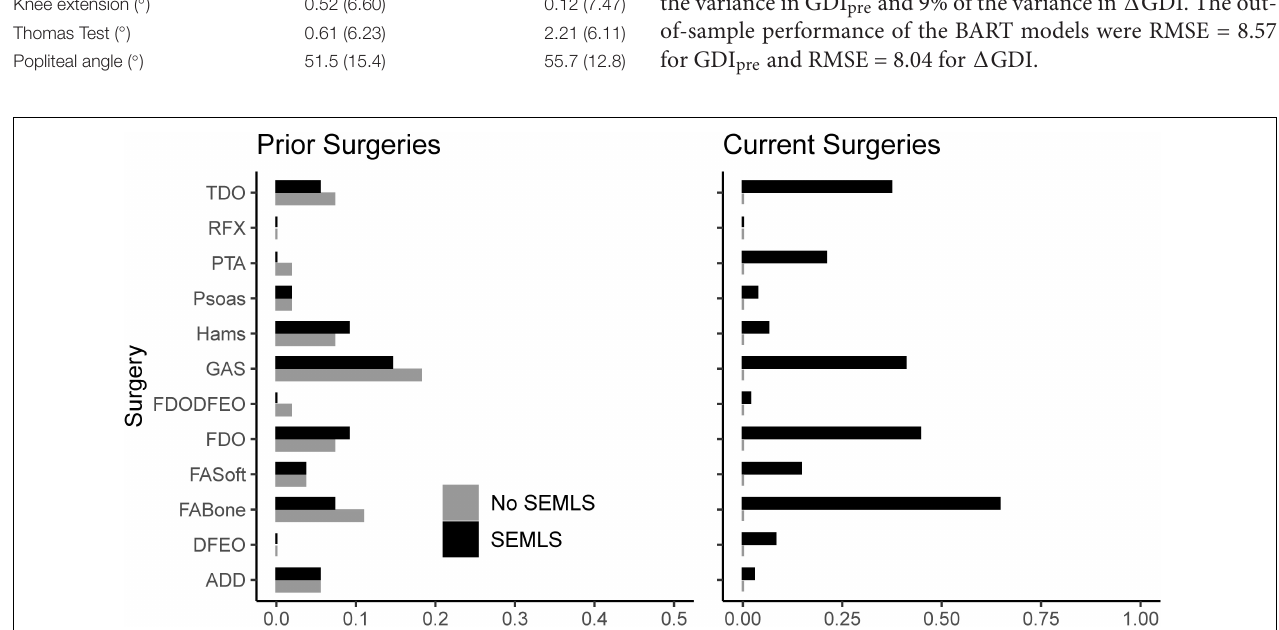
FIGURE 2 | Prior and current surgeries of participants in both cohorts. Note that we excluded potential participants who underwent rectus femors transfer. TDO, tibial derotation osteotomy; RFX, rectus femoris transfer; PTA, patellar tendon advancement; Psoas, psoas lengthening or release; Hams, hamstring lengthening; GAS, plantarflexor lengthening; FDODFEO, distal femoral derotation and extension osteotomy; FDO, femoral derotation osteotomy; FAsoft, foot/ankle soft tissue procedure; FABone, foot/ankle boney procedure; DFEO, distal femoral extension osteotomy; ADD, adductor lengthening or release.